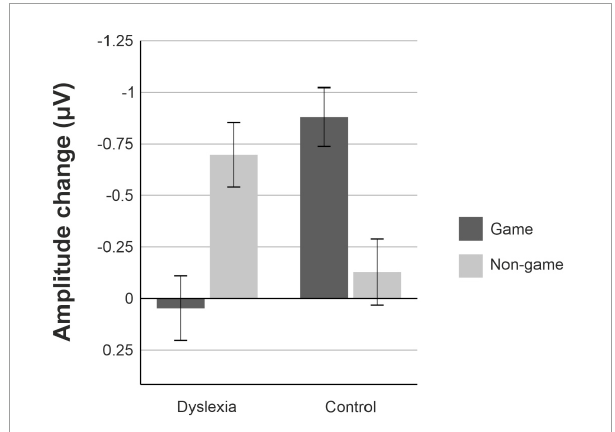
FIGURE4 The mean amplitude changes between the pre-training and post-training measurements for the dyslexia group and the control group. Amplitude changes are averaged over the nine electrodes selected for analysis. Error bars represent the standard error of the